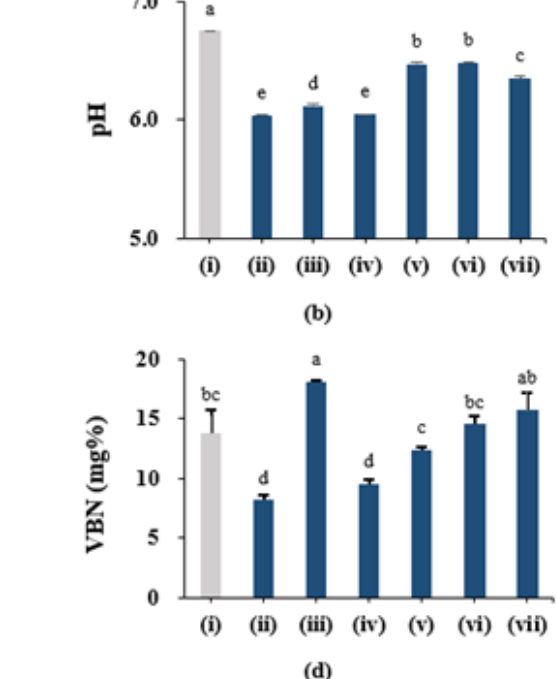
(iii) SHD; (iv) DHD; (v) UFD; (vi) SFD; (vii) DFD. Values are mean ± SD. Different letters (a–f) in each